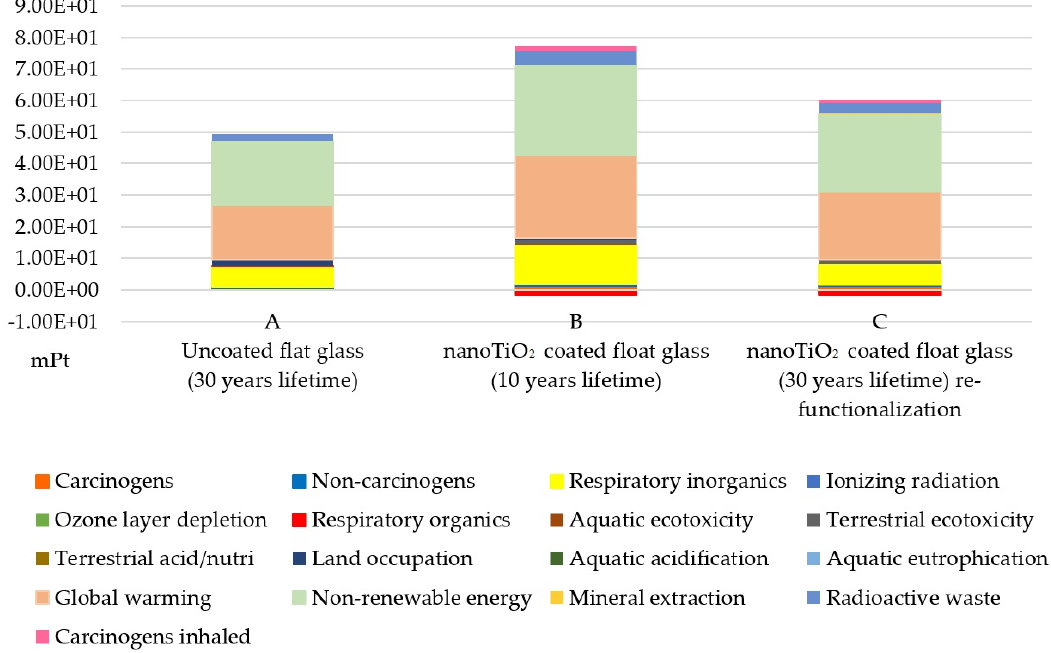
Figure 6. LCIA comparison by single score of 1 m 2 of conventional uncoated flat glass (conventional material) and 1 m 2 of nano ‐ TiO 2 functionalized coated float glasses (innovative materials).